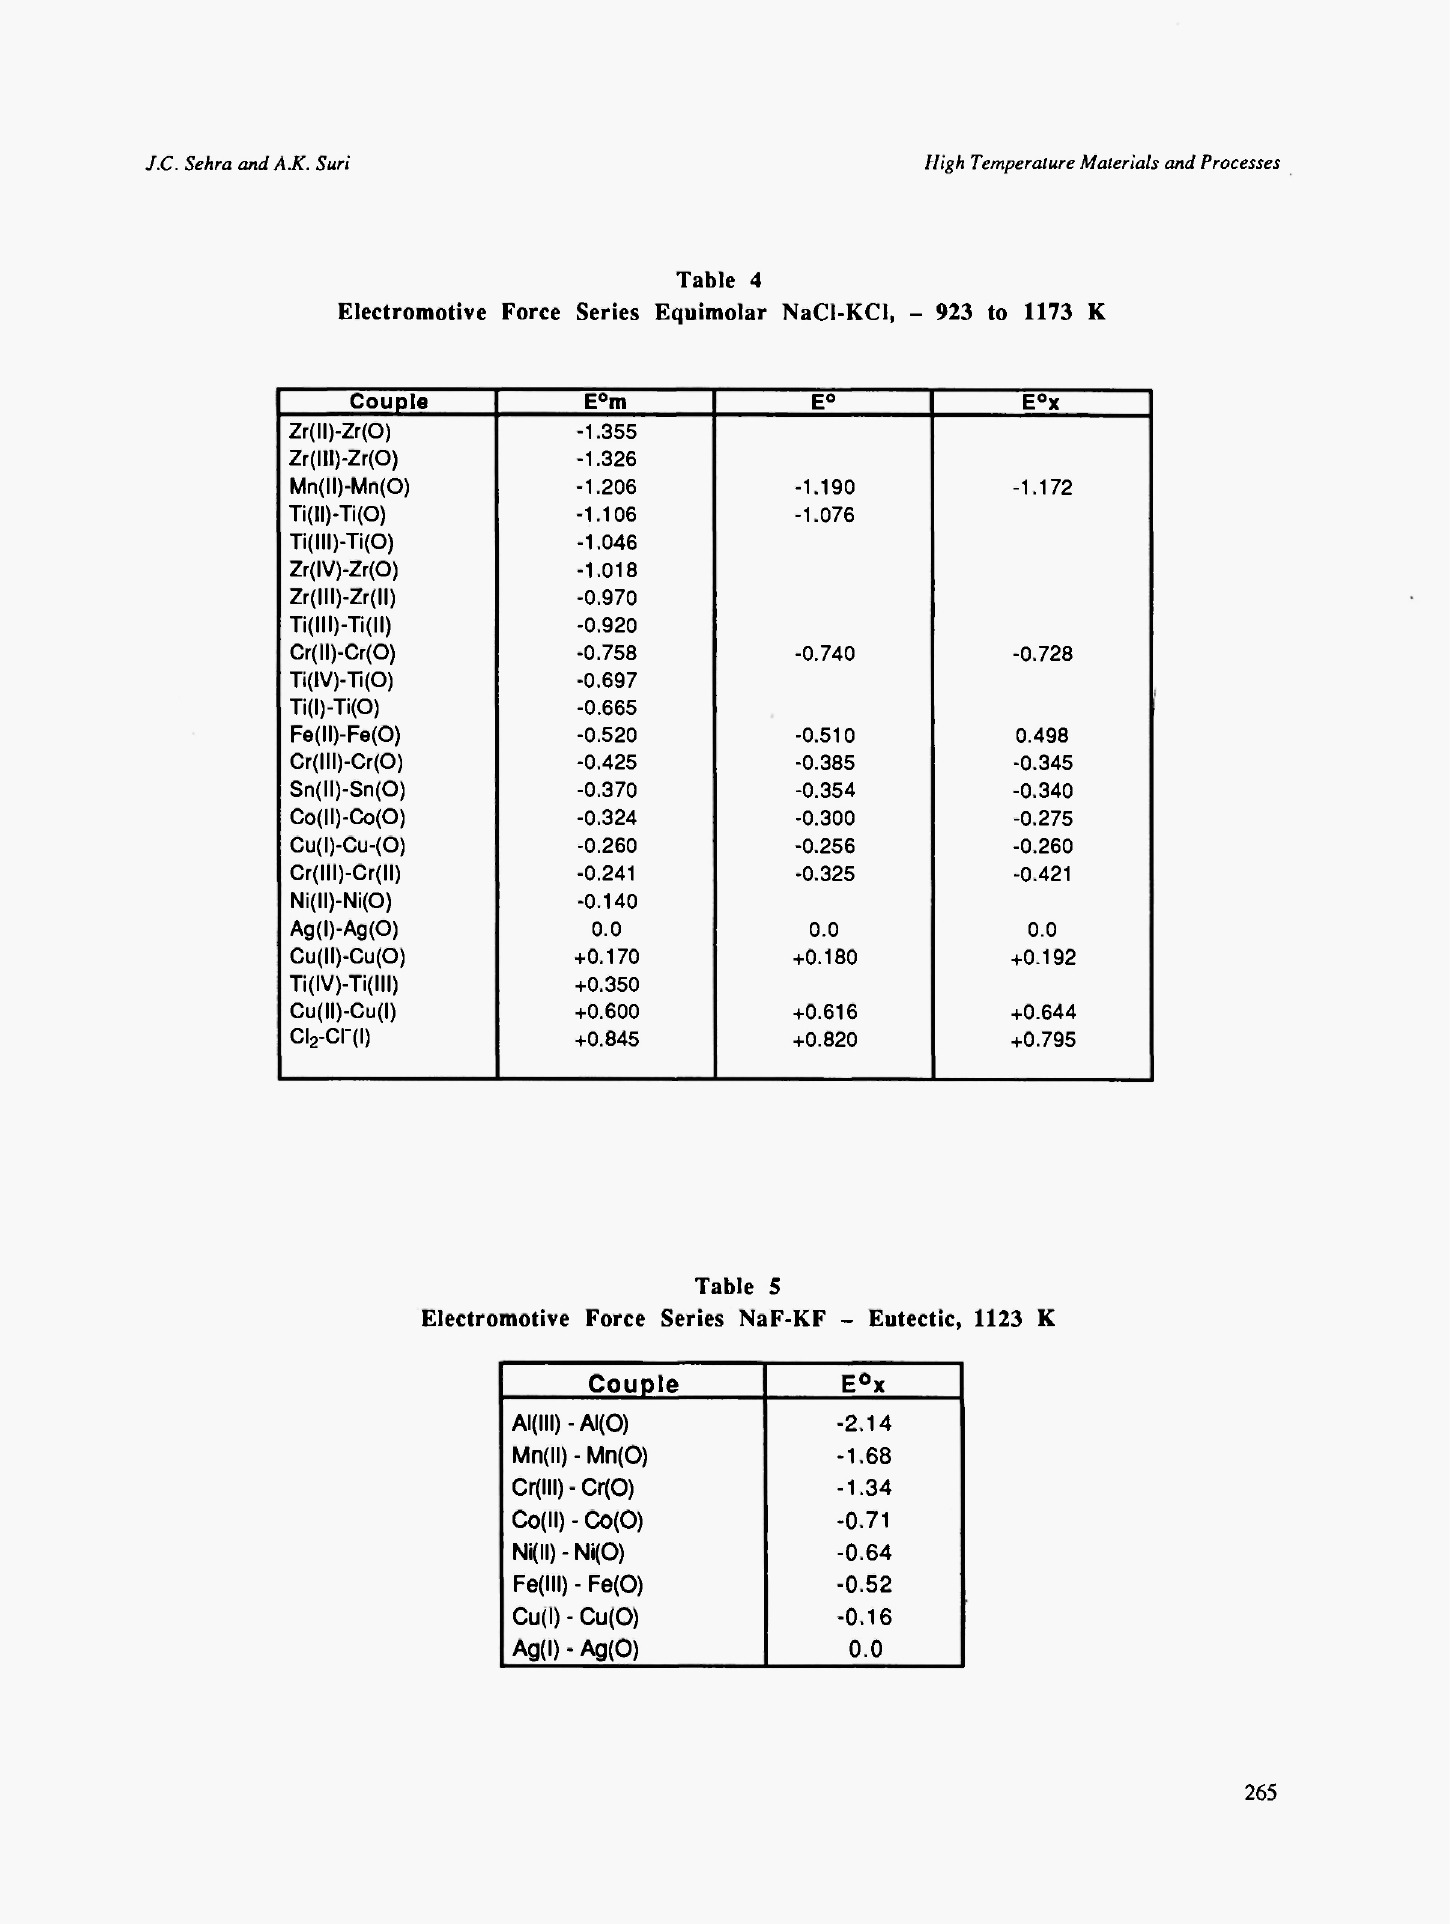
Electromotive Force Series NaF-KF - Eutectic, 1123